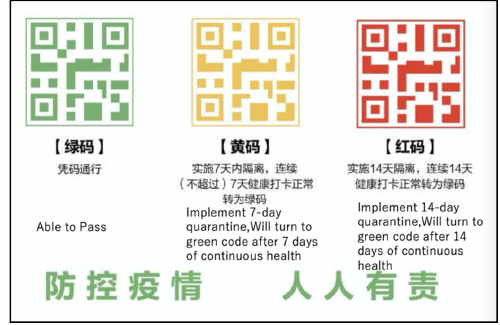
Figure 3. Three color codes used for monitoring people’s movement (Source: https://www.sina.com.cn